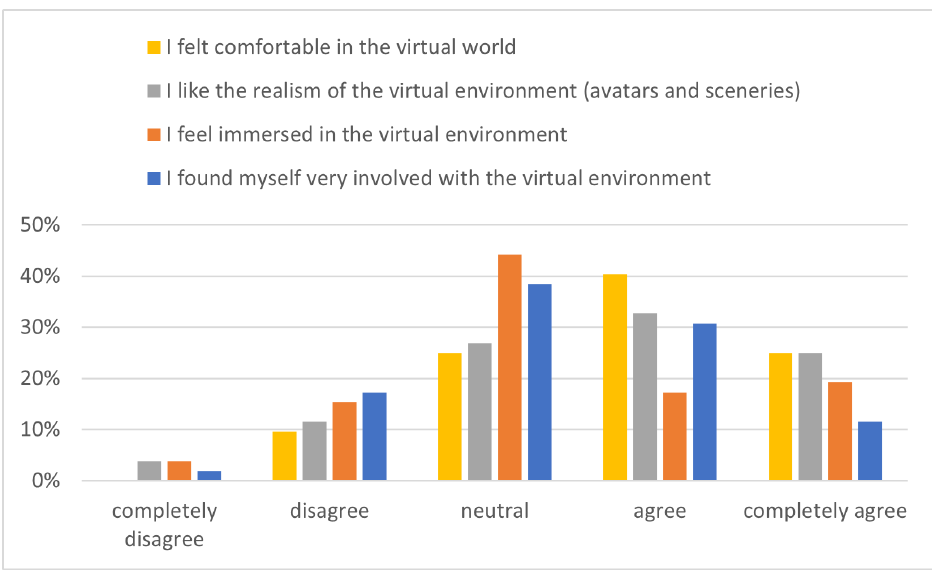
Figure 11. Survey results for ‘Virtual Environment’.